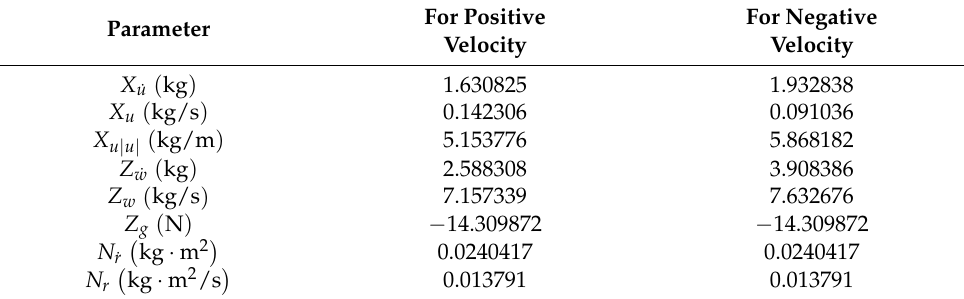
Table 4. Selected estimations of the hydrodynamic parameters. For Positive For Parameter